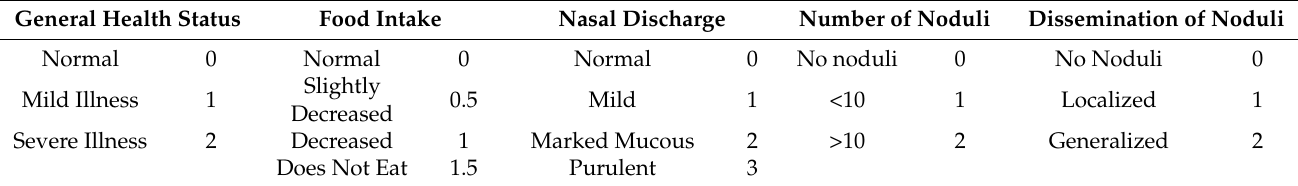
Table 1. Clinical scoring system. The animals were monitored daily and scored using the scoring system in this table.